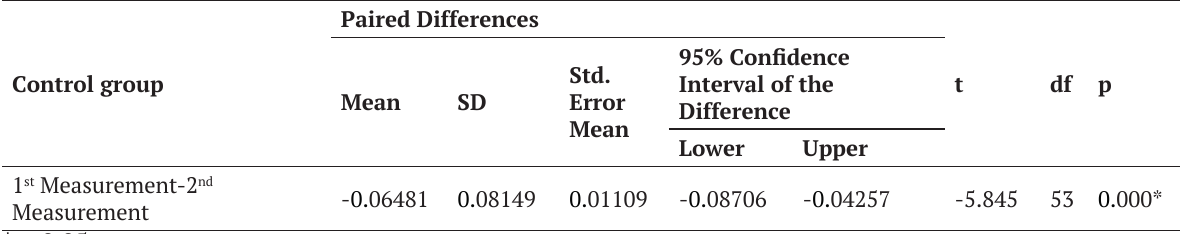
1 st Measurement-2 nd